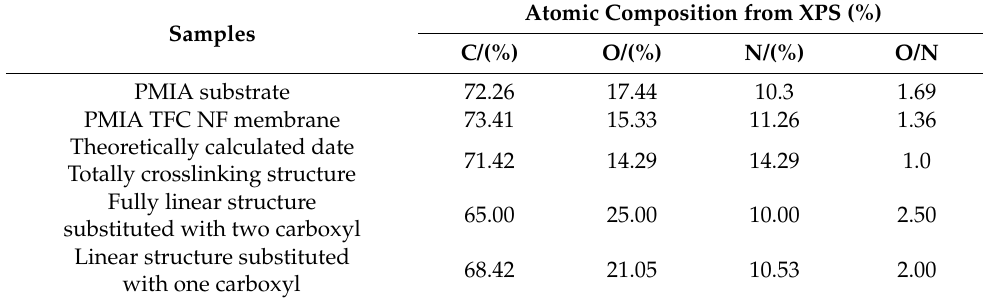
Table 3. XPS analysis membrane